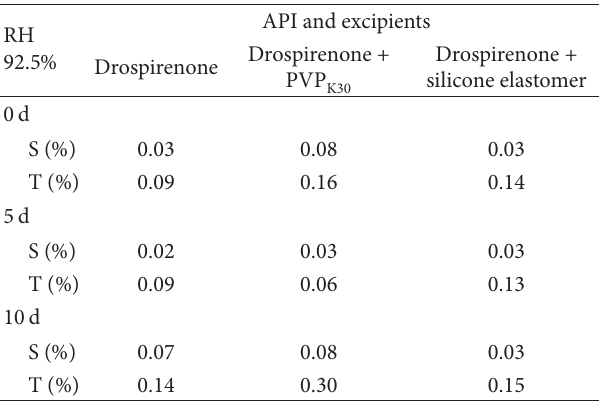
T 7: e results of API excipients compatibility testing